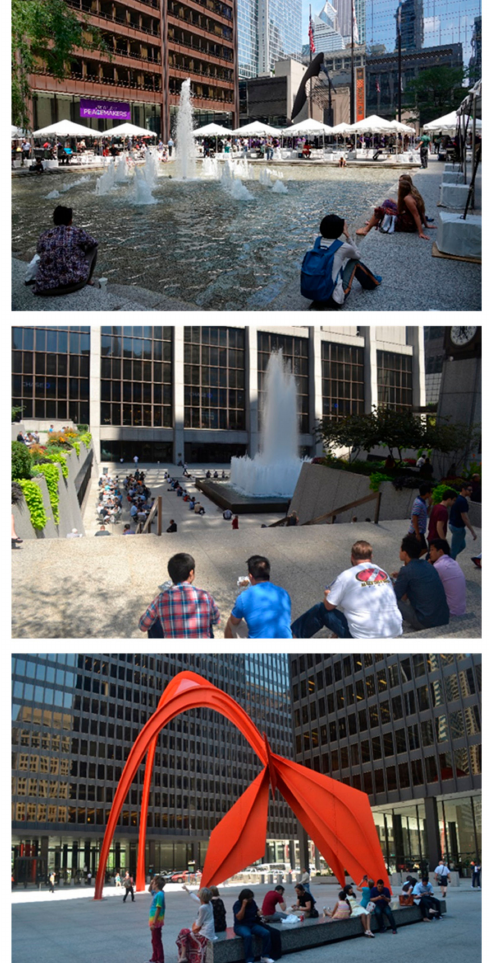
Figure 10. Inner Loop: Daley Plaza, Chase Plaza, and Federal Plaza, respectively. Participants felt that these plazas o ff er respite from the stressful, busy